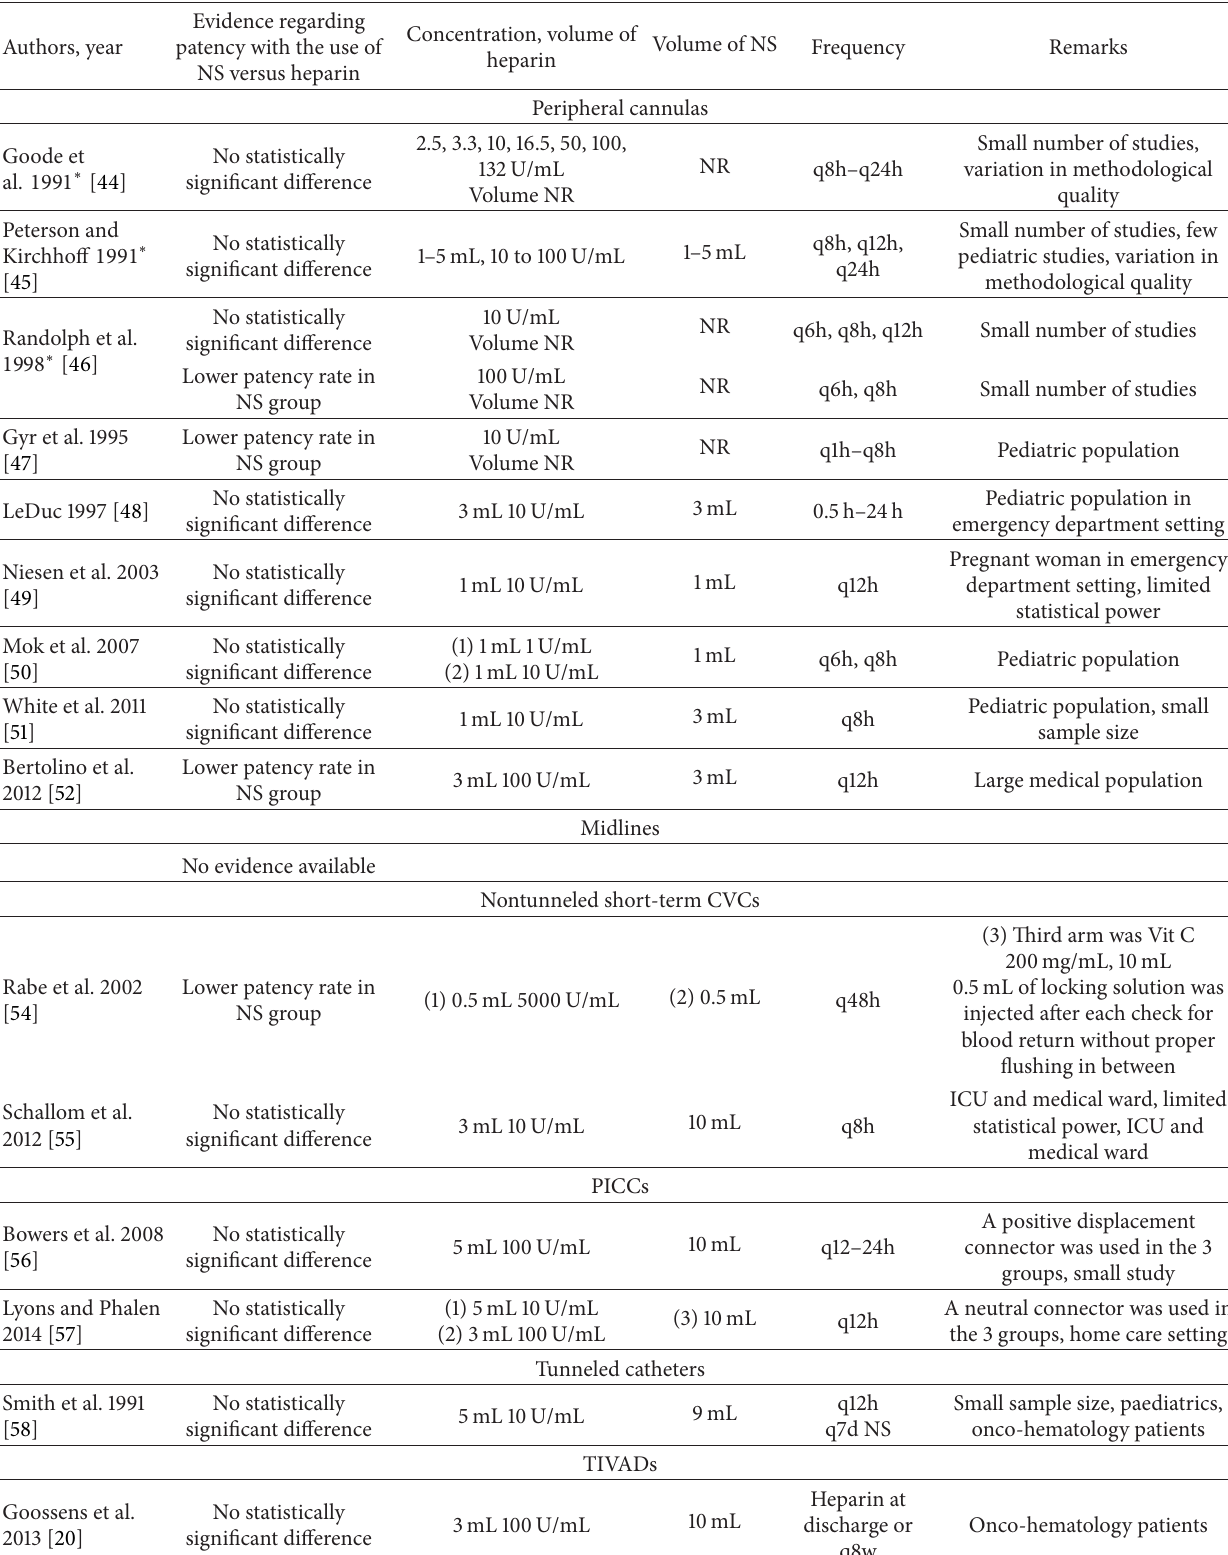
Table 5: RCTs and meta-analyses comparing NS and heparin as locking